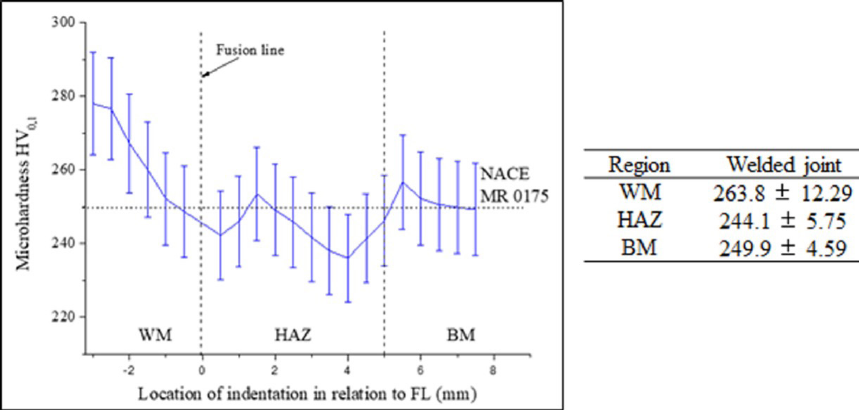
Figure 11. Average Vickers microhardness profiles of the WM, HAZ and BM regions.